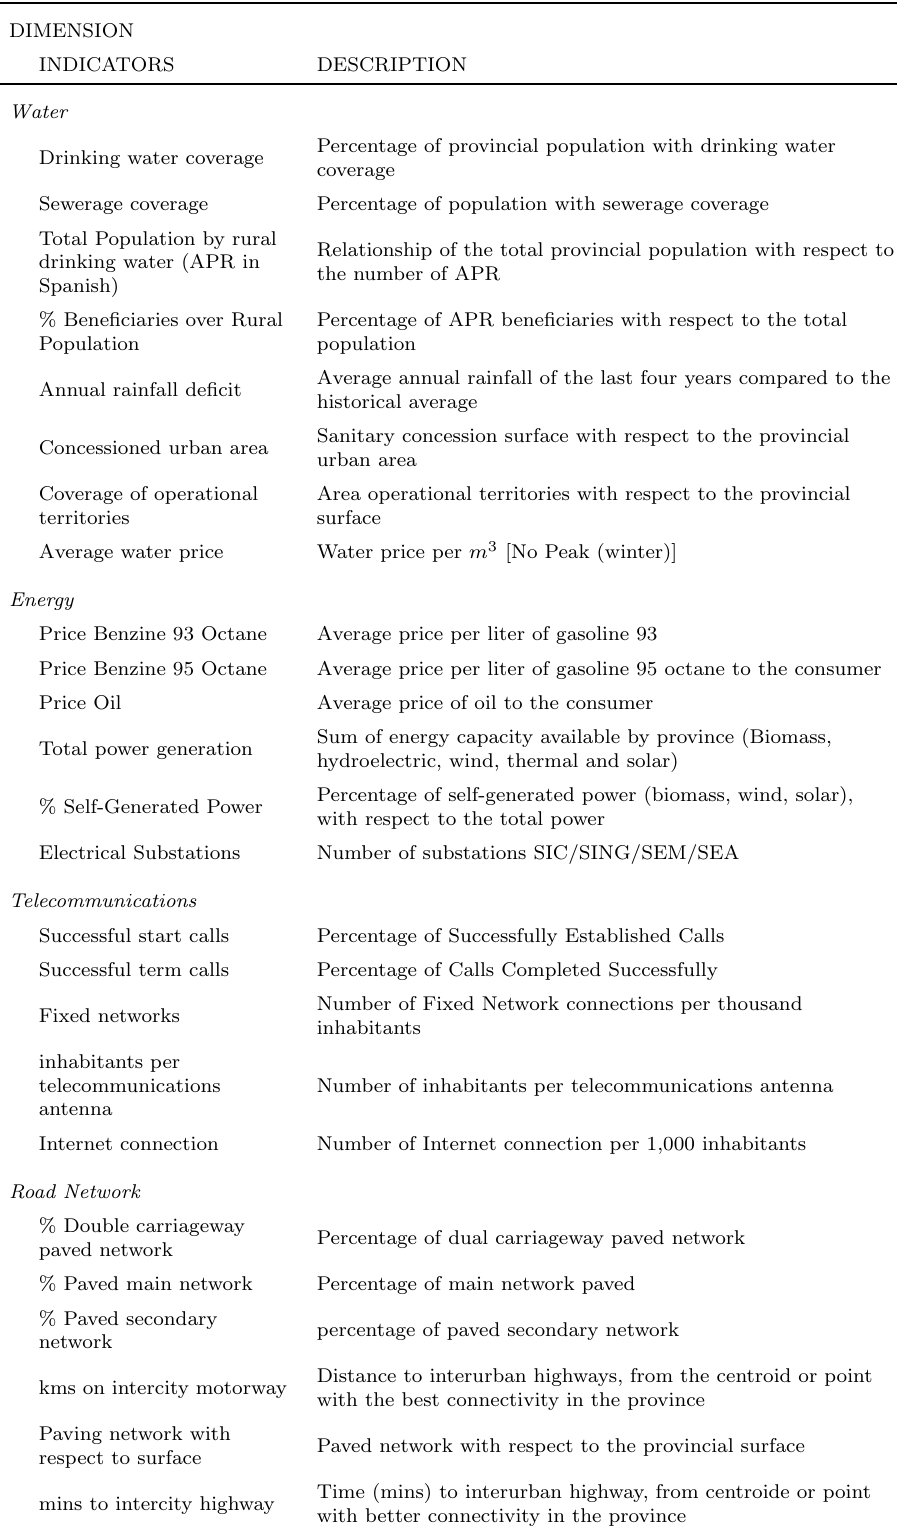
Table A.1: List of